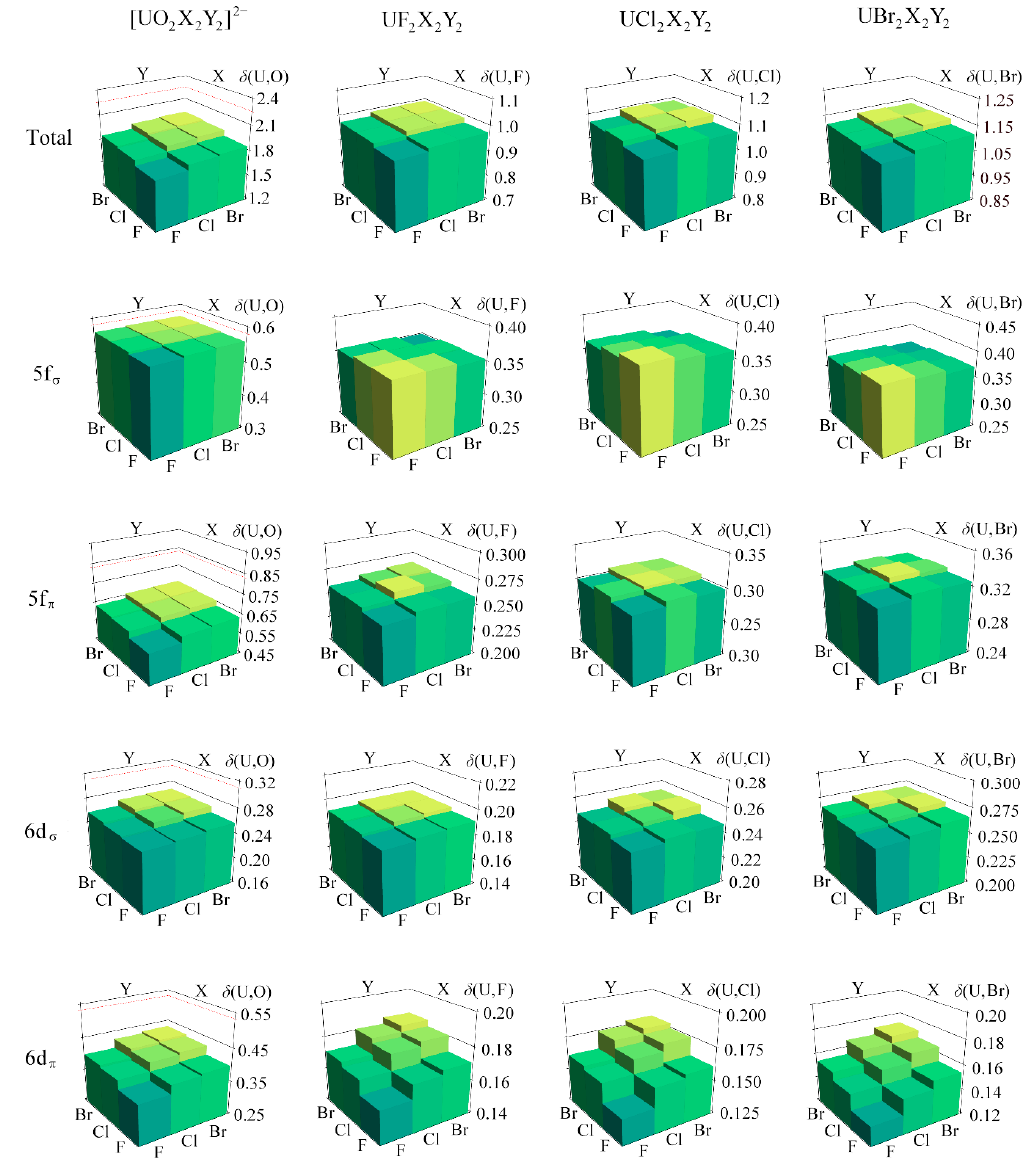
Figure 5. Delocalization indices of axial U–O and U–X (X = F, Cl, Br) bonds in [UO 2 X 2 Y 2 ] 2 − and UX 2 Y 2 Z 2 complexes derived from B3LYP-generated densities. All values are in a.u.